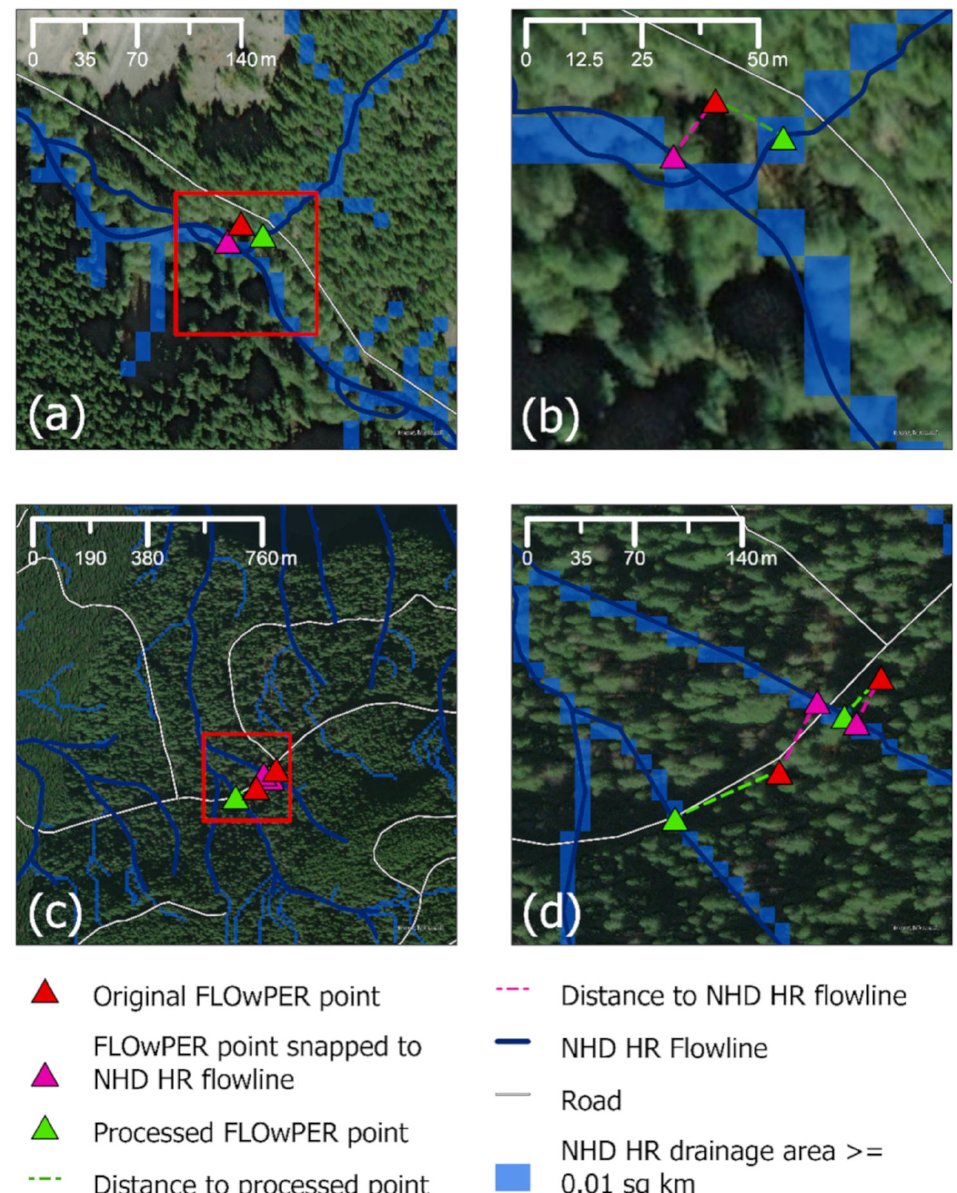
Figure 5. Examples of the challenge of assigning field observation to a stream network, in this case, the NHD High Resolution flowline and NHD High Resolution flow accumulation stream grid. Red triangles are original points, pink triangles are the point snapped to the closest NHD High Resolution flowline, and green triangles are the final processed locations on the NHD High Resolution flowlines and flow accumulation derived stream grid network. ( a ) An observation collected near a valley bottom is near the mainstem and a tributary that intersects the road. ( b ) Inset of ( a ). The original point is closer to the mainstem NHD flowline, though the snapping distance to the tributary is nearly equal. Information interpreted from the FLOwPER field form indicates that the observation should be assigned to the tributary. ( c ) Two observations collected in the headwaters along a road. ( d ) Inset of ( c ). The two original points are both closest to the flowline to the east. However, information interpreted from the FLOwPER field form and interpretation of the map indicate that the western observation should be assigned to the western